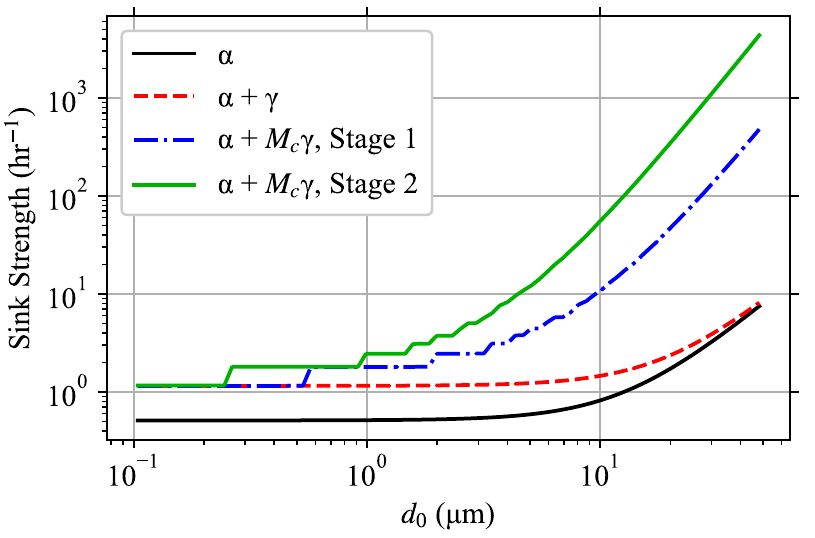
Fig 4. Sink strength by bin. The strength of the sink terms for each bin with 80 bins, which is α without inactivation, α + γ for k = 1, and α + M c γ for k = M c (different values for Stage 1 and 2).